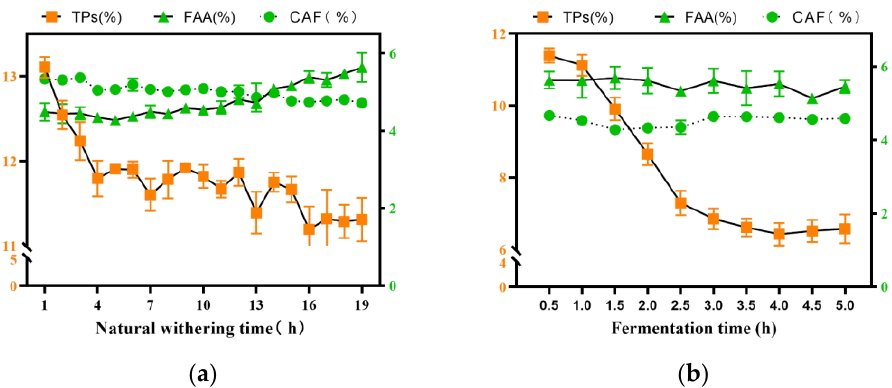
Figure 2. Changes of TPs, FAA, and CAF contents during withering and fermentation of fresh tea leaves. ( a ) Changes of quality components during tea withering; ( b ) changes of quality components during tea fermentation.